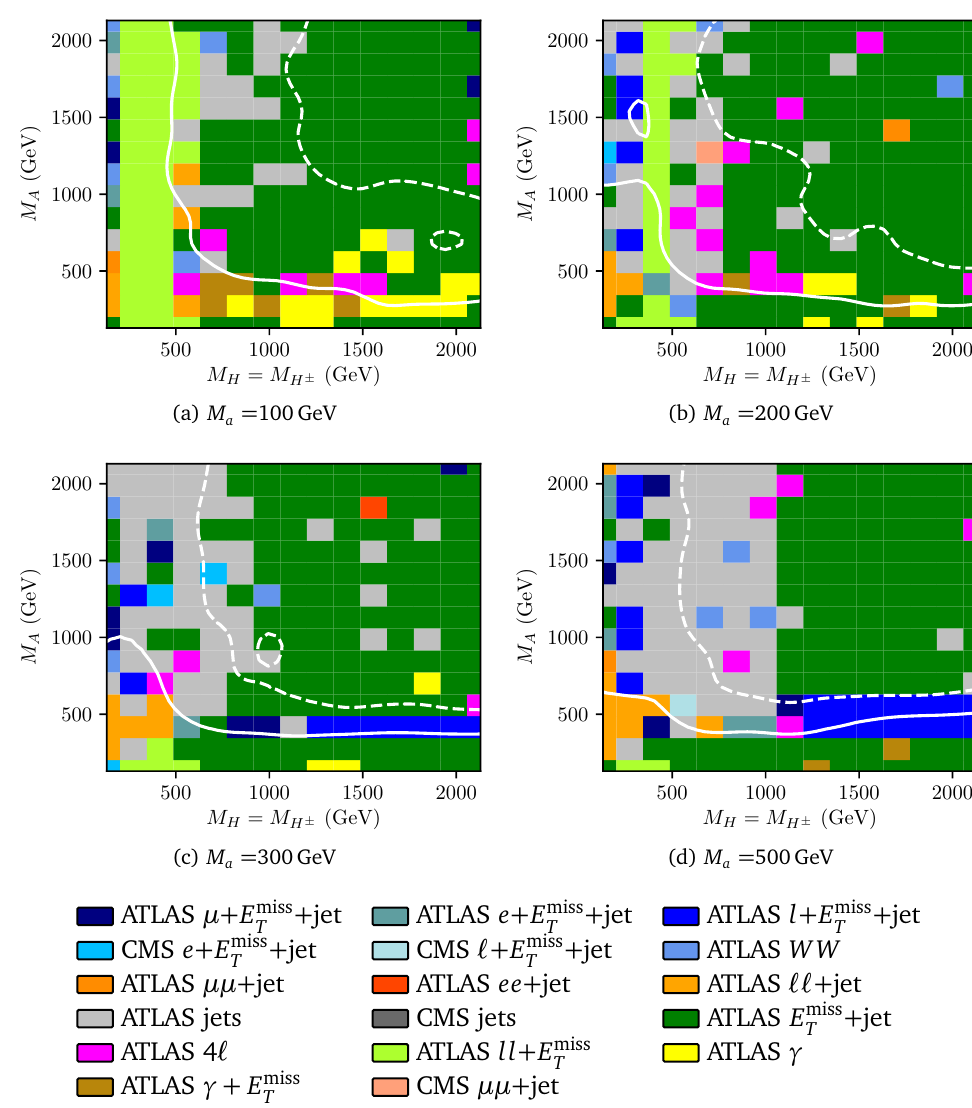
= M vs M for different M . The 95% (68%) A H H ± a